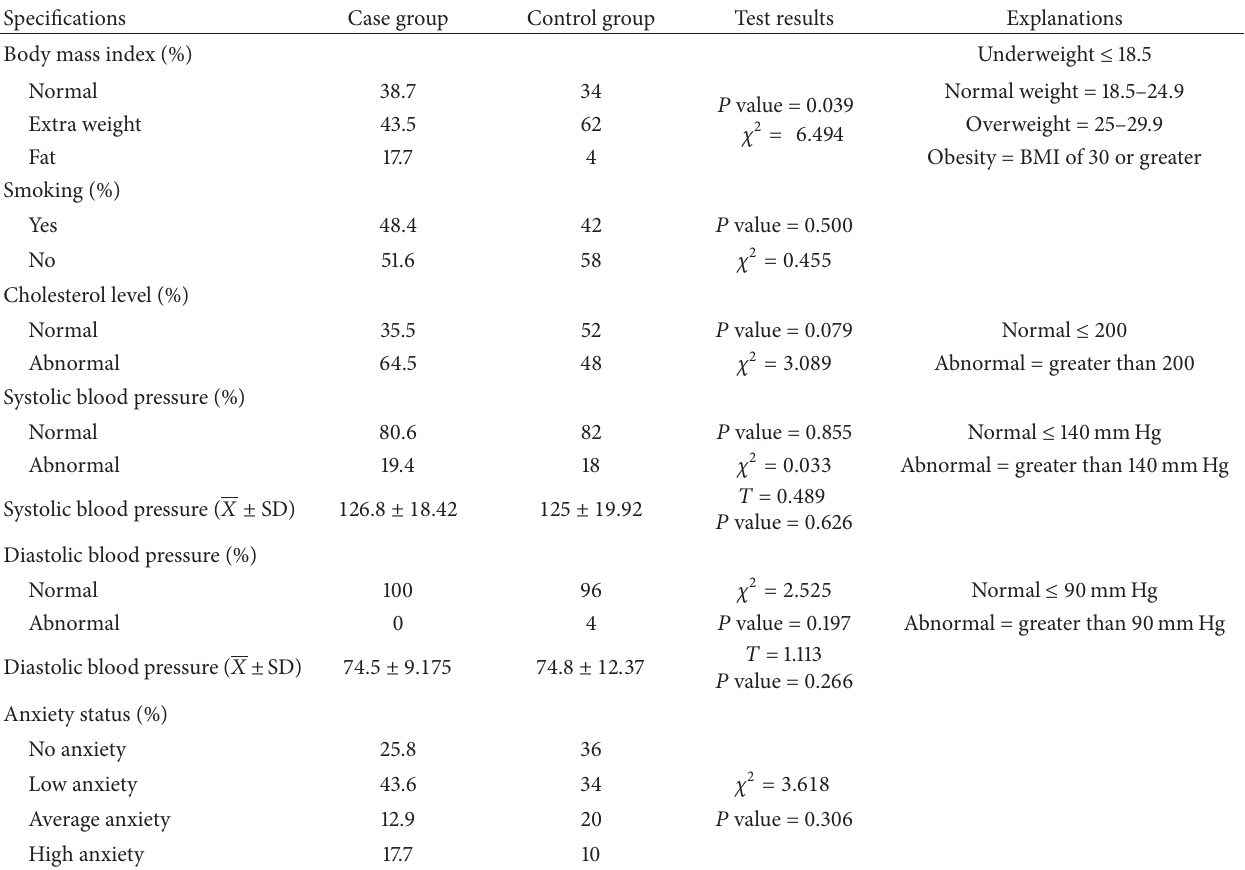
Table 1: Determination and comparison of level of anxiety, body mass index, cholesterol, blood pressure, and quitting smoking before education in the patients with myocardial infarction in the case and the control